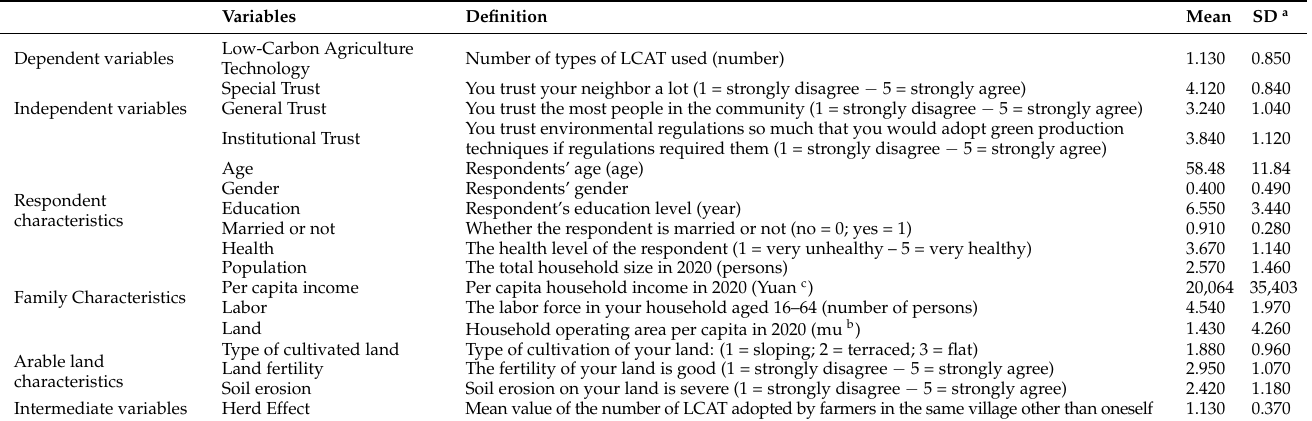
Table 1. Variable definition and descriptive